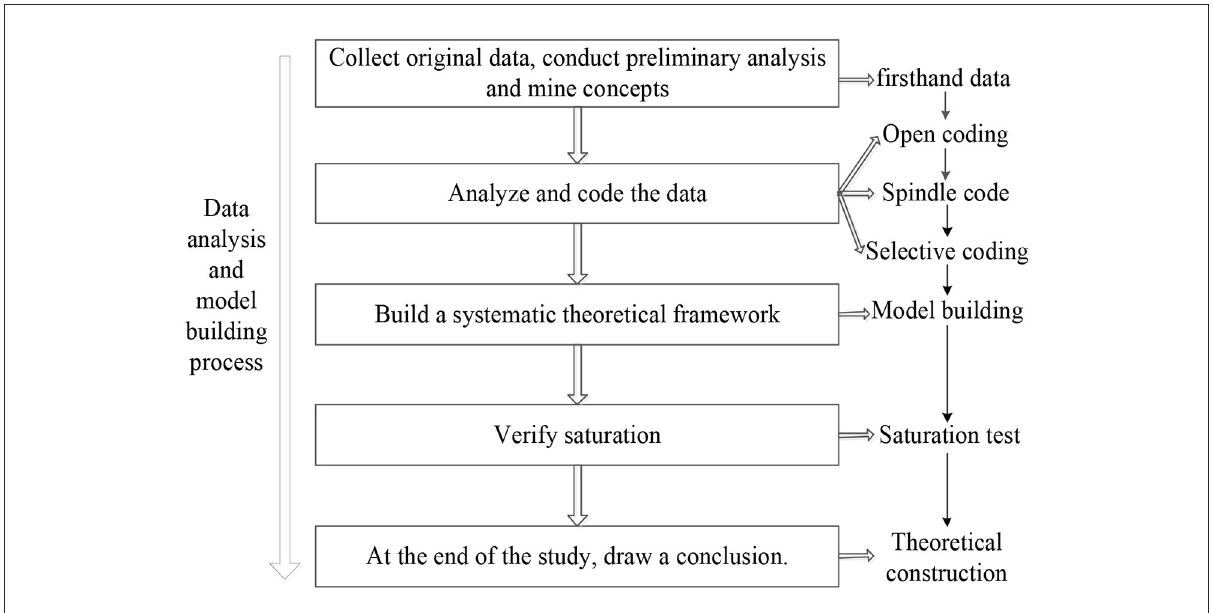
FIGURE1 The coding process of grounded